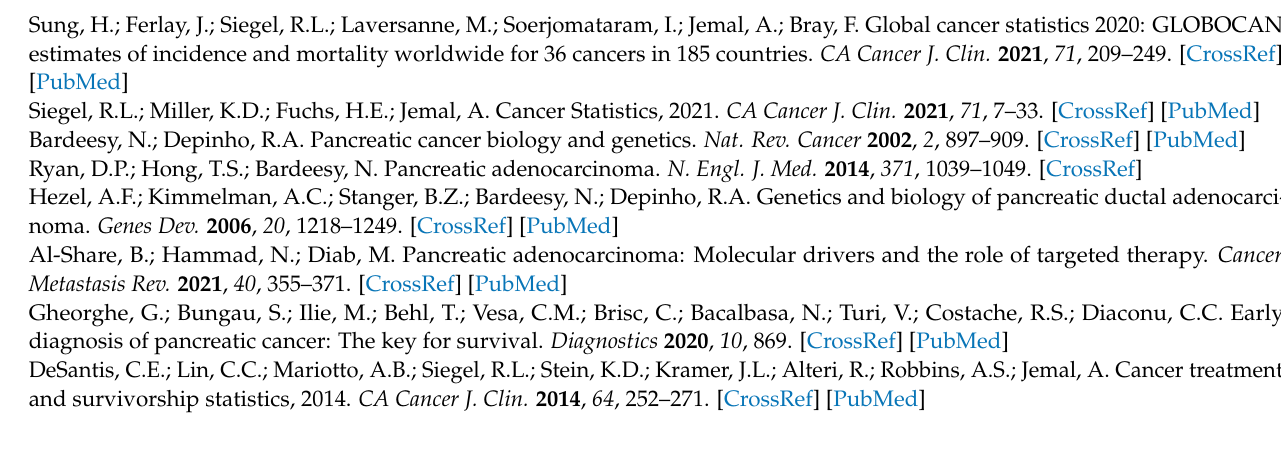
and controls. Table S2: Differentially expressed miRNAs between long survival PDAC patients and controls. Table S3: Differentially expressed miRNAs between short survival PDAC patients and controls. Table S4: Differentially expressed miRNAs between short and long survival PDAC patients. Table S5: miRNA’s putative targets prediction by miRTarBase. Table S6: KEGG pathways. Table S7: Wnt signalling pathway. Table S8: p53 signalling pathway. Table S9. TGF-beta signalling